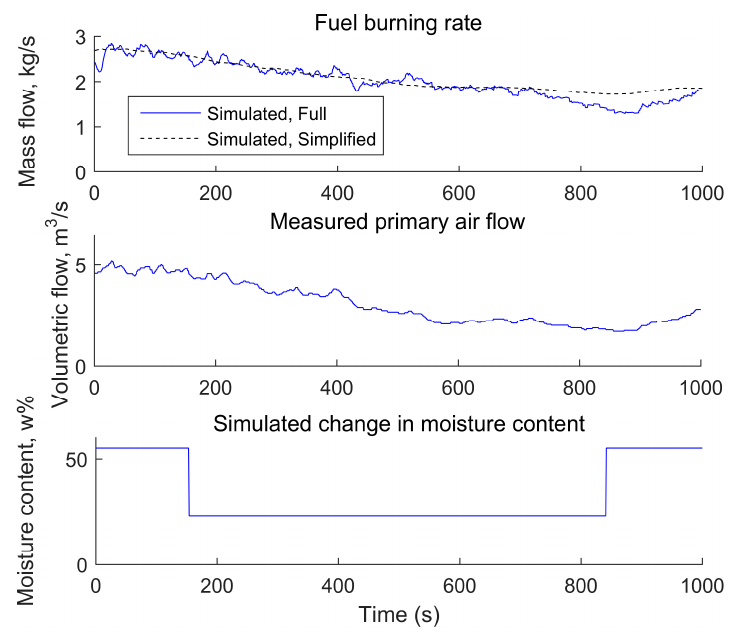
Figure 8. Comparison of the predictions from mechanistic to the ones from the simplified model.